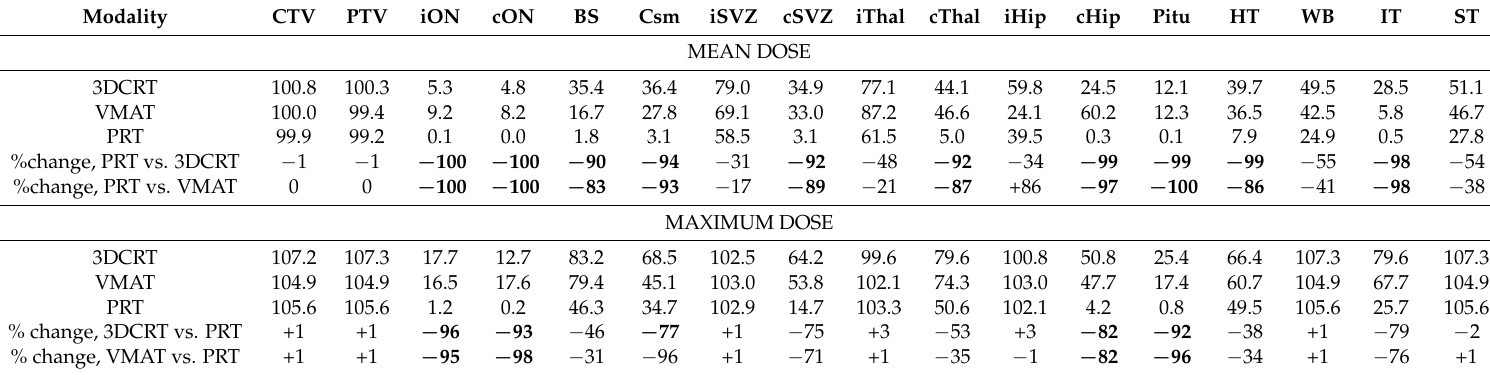
Table 5. Median values for mean and maximum doses to target volumes and organs-at-risk by radiotherapy modality for parietal tumors.